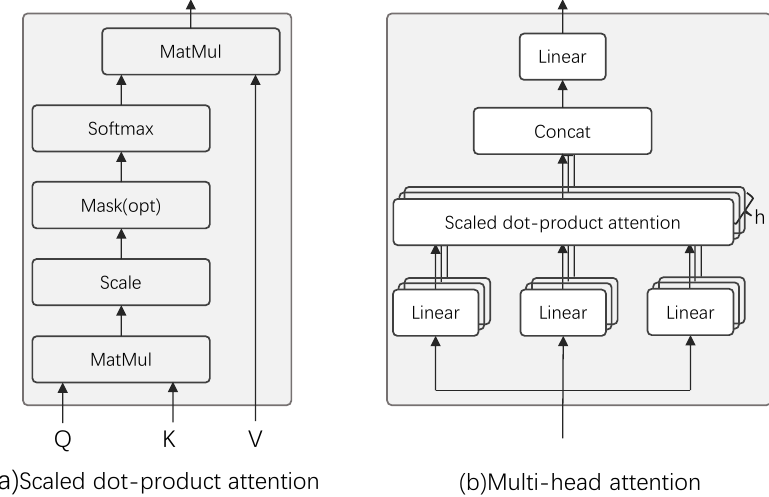
Figure 6. Attention mechanism in transformer.